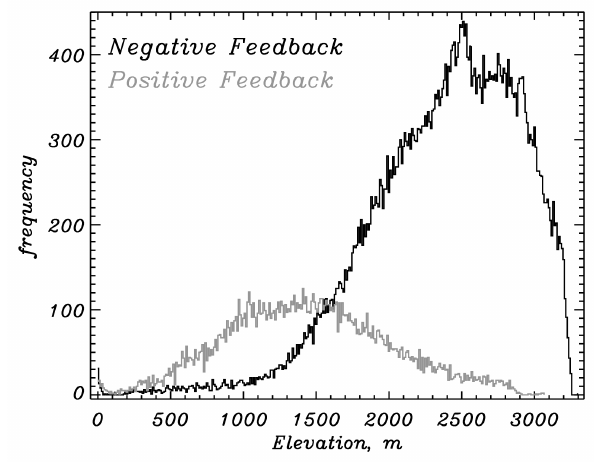
Fig. 14. Elevational histograms of temporally detrended albedo feedback for the whole ice sheet for 5km grid cells used in this